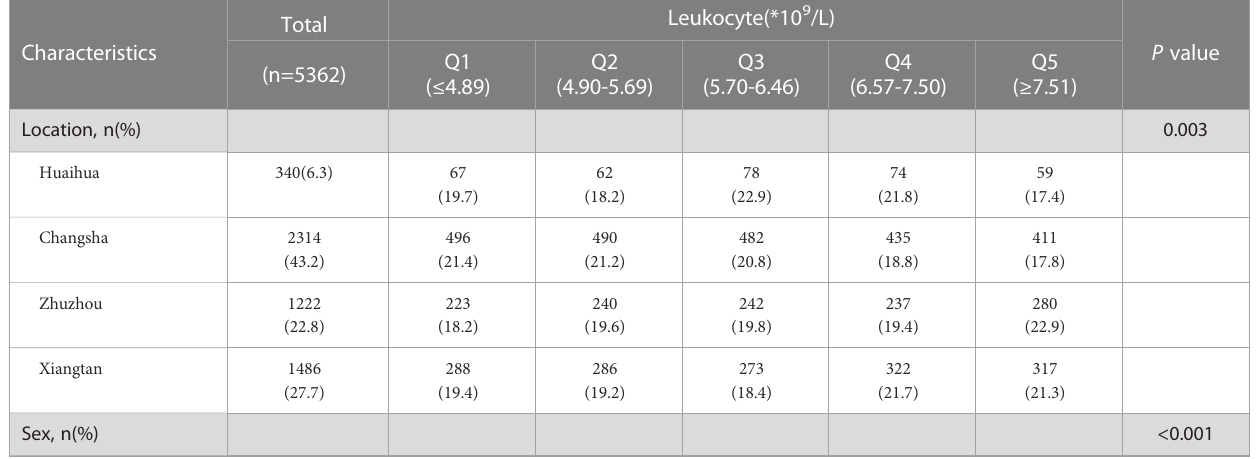
TABLE 4 Baseline characteristics of people without type 2 diabetes at baseline across leukocyte quintiles.